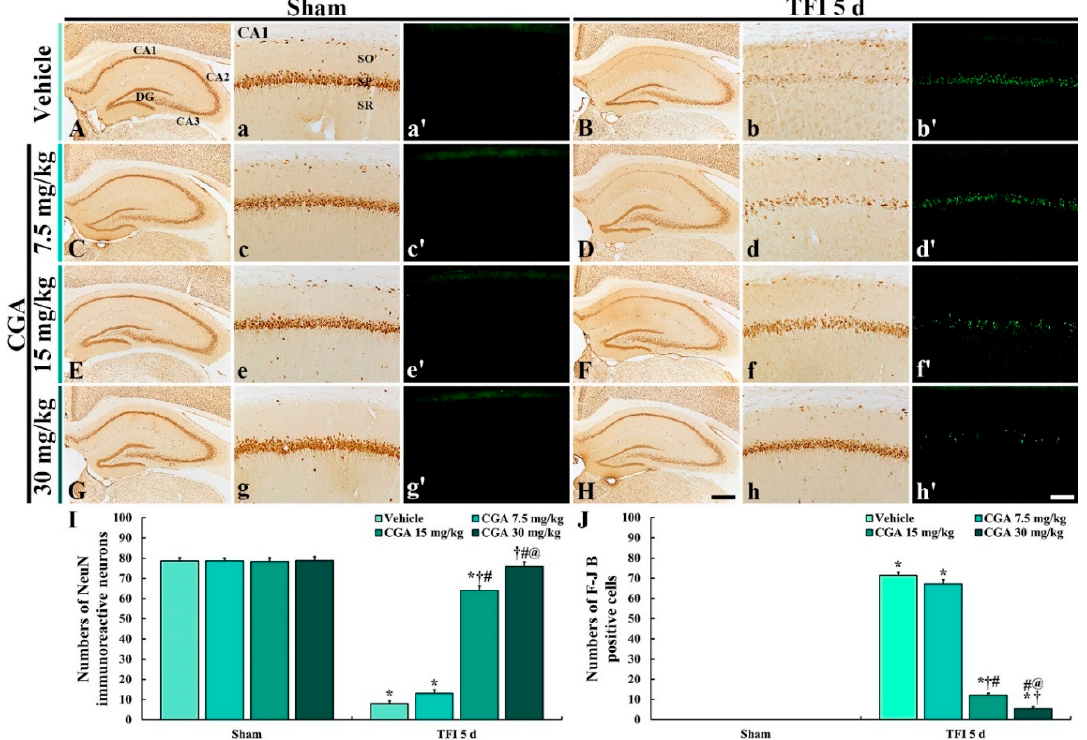
Figure 2. NeuN immunohistochemistry ( A – H , A ( a )– H ( h )) and ( F – J ) B histofluorescence ( A ( a’ )– H ( h’ )) in the hippocampus ( A – H ) and CA1 region ( A ( a )– H ( h ), A ( a’ )– H ( h’ )) of the vehicle/sham and vehicle/TFI ( A ( a , a’ ), B ( b , b’ )), 7.5 mg/kg CGA/sham and CGA/TFI ( C ( c , c’ ), D ( d , d’ )), 15 mg/kg CGA/sham and CGA /TFI ( E ( e , e’ ), F ( f , f’ ) and 30 mg/kg CGA/sham and CGA/TFI ( G ( g , g’ ), H ( h , h’ )) groups at 5 days after TFI. NeuN + neurons are markedly reduced in the stratum pyramidale (SP) of the CA1 region of the vehicle/TFI group. Numerous F-J B + cells are observed in the SP of the vehicle/TFI, 7.5 mg/kg CGA/TFI and 15 mg/kg CGA/TFI groups. In the 30 mg/kg CGA/TFI group, numerous NeuN + neurons and no F-J B + cells are detected in the SP. DG, dentate gyrus; SO, stratum oriens; SP, stratum pyramidale; SR, stratum radiatum. Scale bars = 400 μ m ( A – H ) 40 μ m ( A ( a )– H ( h ), A ( a’ )– H ( h’ )). I and J: mean numbers of NeuN + ( I ) and F-J B + cells ( J ) in the SP of the CA1 region. The bars indicate the means ± SEM ( n = 7 in each group, * p < 0.05 vs. the corresponding sham group, † p < 0.05 vs. the vehicle/TFI group, # p < 0.05 vs. the 7.5 mg/kg CGA/TFI group, @ p < 0.05 vs. the 15 mg/kg CGA/TFI group).